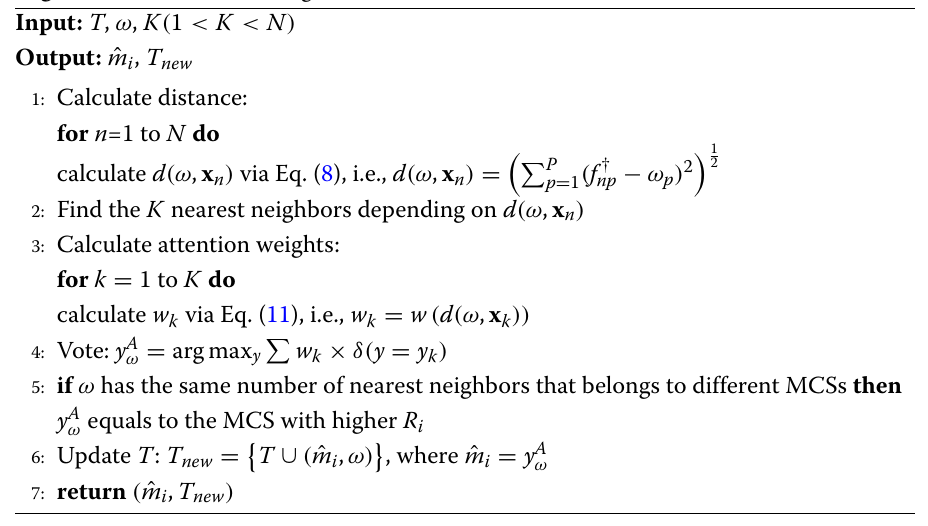
Algorithm 1 Online learning A- k NN based